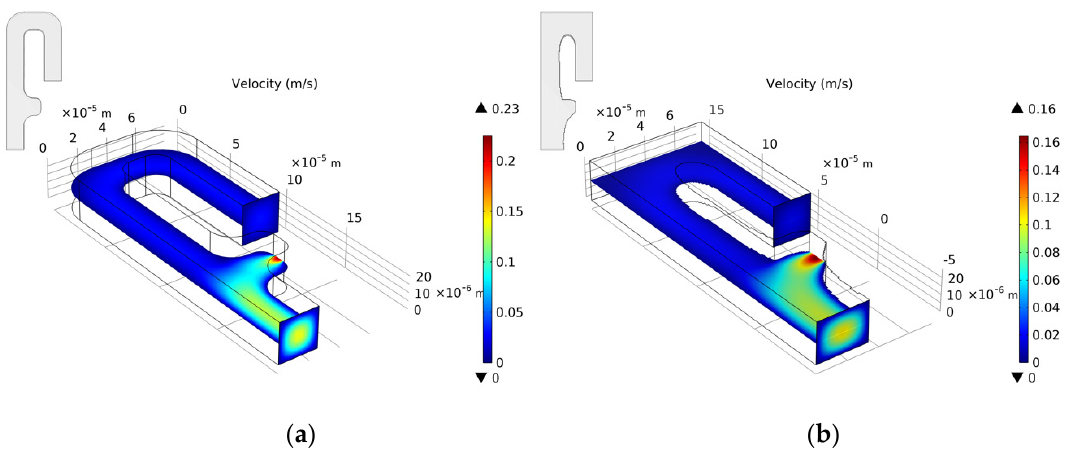
Figure 17. ( a ) The flow field distribution of the optimized structure in [25] and ( b ) the flow field distribution of the optimized structure in this paper of single-cell capture model.